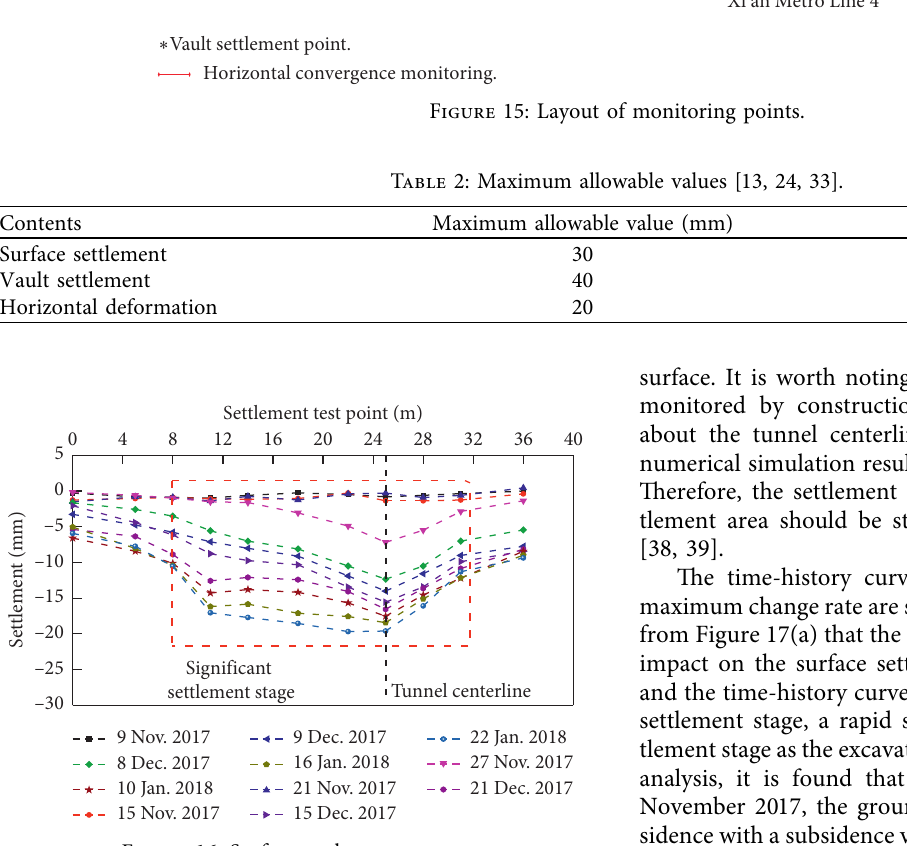
Figure 16: Surface settlement